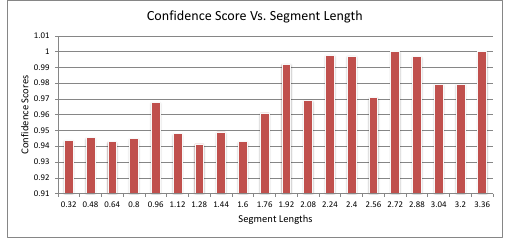
Figure 2: Confidence Scores for different segment lengths of a sample audio As human voice ranges approximately 300 Hz to 4000 Hz,